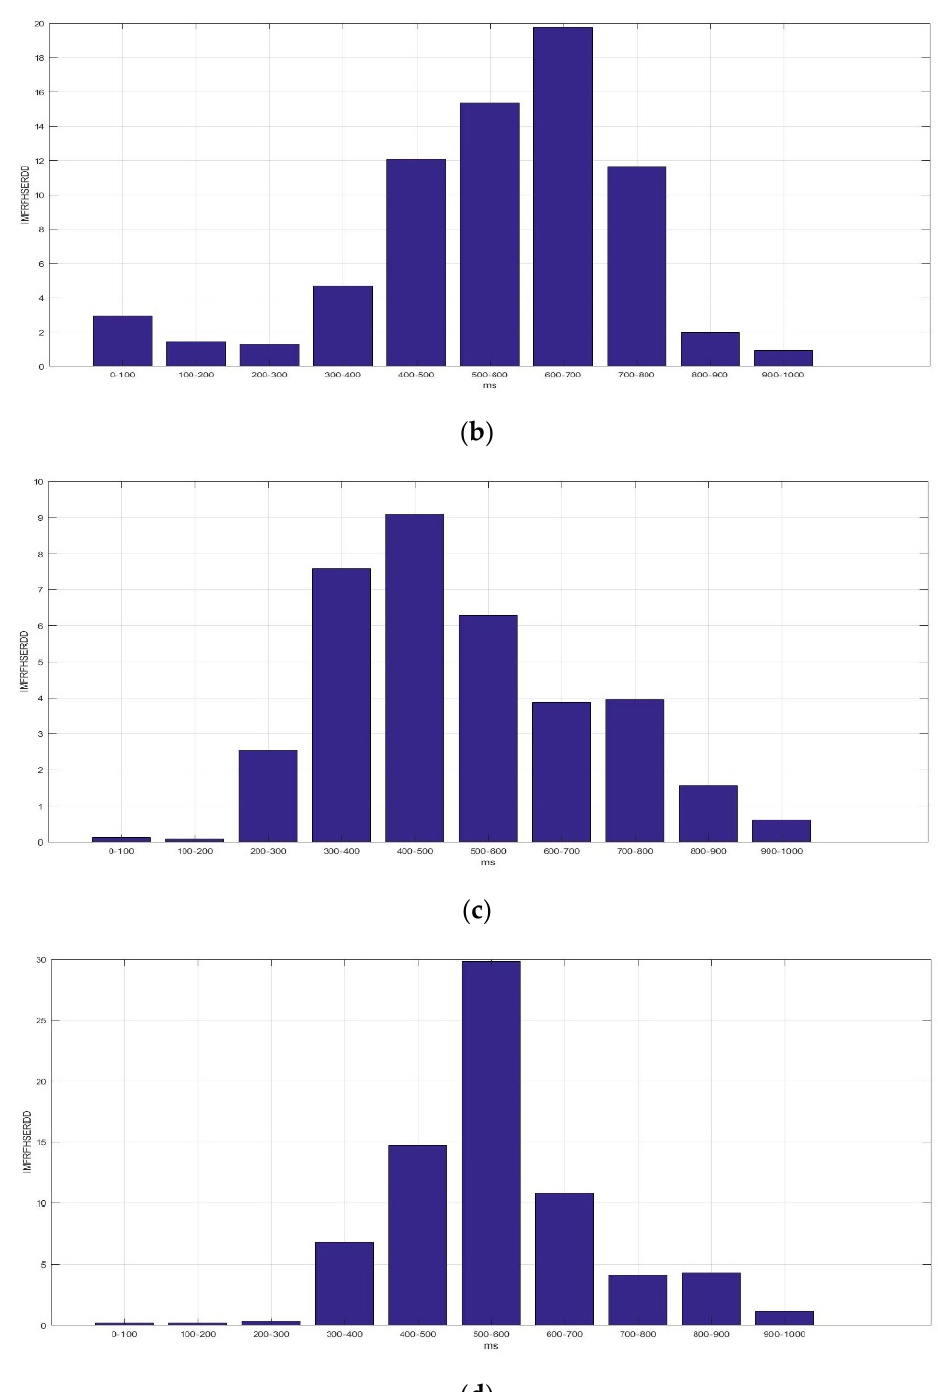
Figure 8. Average IMFRFHSERDD values of IMF3 (HS3) for the delta rhythm during time interval of 0–1000 ms for F5AM, F5MI, F6AM, and F6MI, respectively. ( a ) Average IMFRFHSERDD values (F5AM HS3, 0.5–4 Hz), ( b ) average IMFRFHSERDD values (F5MI HS3, 0.5–4 Hz), ( c ) average IMFRFHSERDD values (F6AM HS3, 0.5–4 Hz), and ( d ) average IMFRFHSERDD values (F6MI HS3, 0.5–4 Hz).